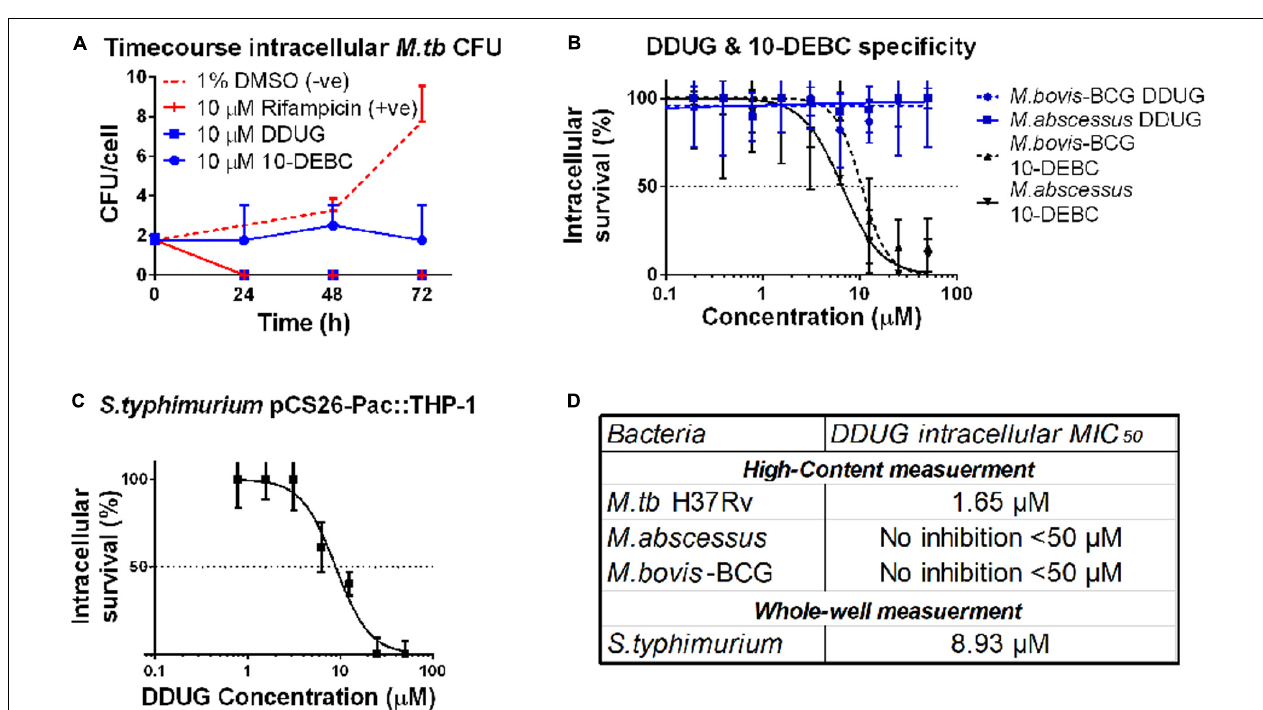
FIGURE 4 | DDUG Mode of intracellular inhibition and Mycobacteria specificity. Intracellular CFU calculated by normalizing to number of THP-1 cells, treated with DDUG (blue squares) or 10-DEBC (blue circles) or controls (red) (A) . Compound specificity was compared by challenging pathogenic mycobacteria ( M. abscessus , solid line; M. bovis -BCG, dotted line) with DDUG (blue) or 10-DEBC (black) in an intracellular dose-dependency assay, normalized to 1% DMSO (0% inhibition) and 4 µ M bedaquiline (100% inhibition) (B) . DDUG inhibition of luciferase-expressing S. typhimurium growth in infected THP-1 cells (C) . Error bars represent the SEM from four (A,B) or six (C) independent trials. Comparison of DDUG intracellular effect on different bacteria (D) .